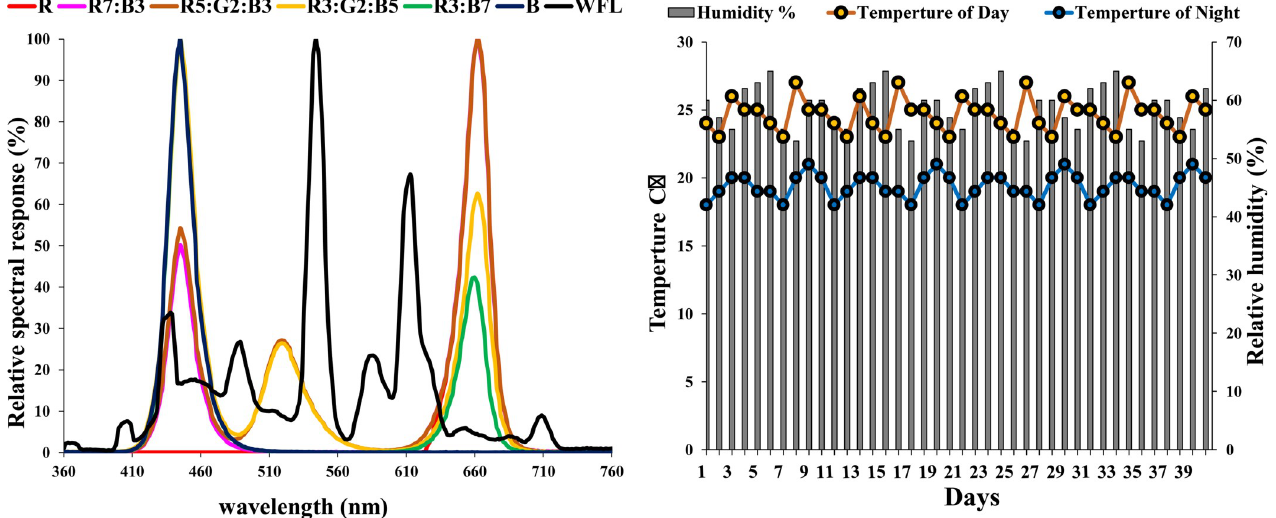
Fig 1. Relative spectral response (%) of the treatments in chambers and environmental conditions.